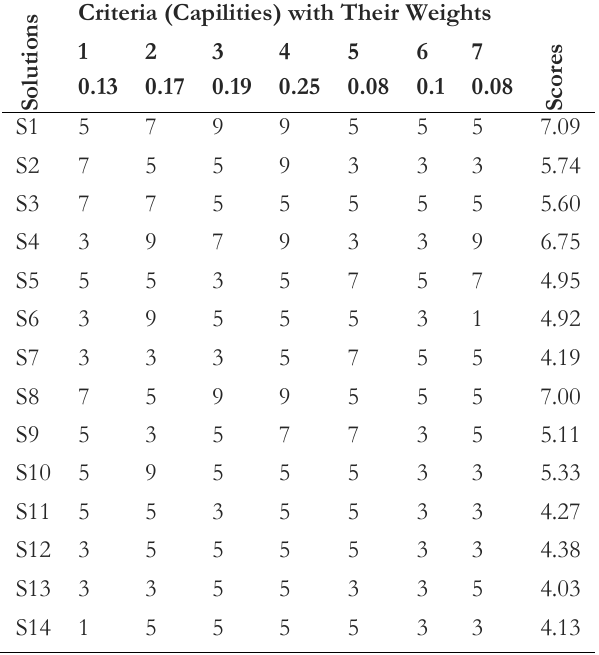
Table 5. The first expert scores for the proposed